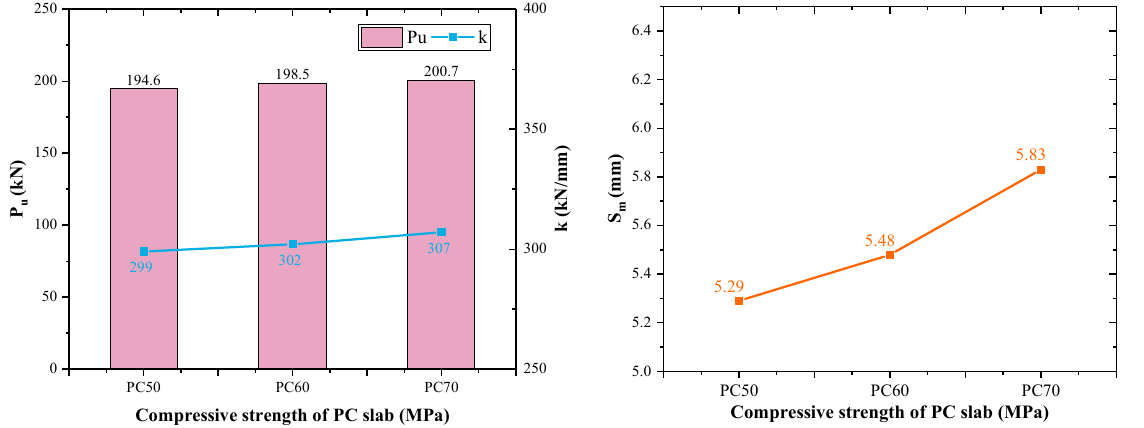
Figure 30. Influence of compressive strength of precast concrete on ultimate strength and shear stiff- ness.